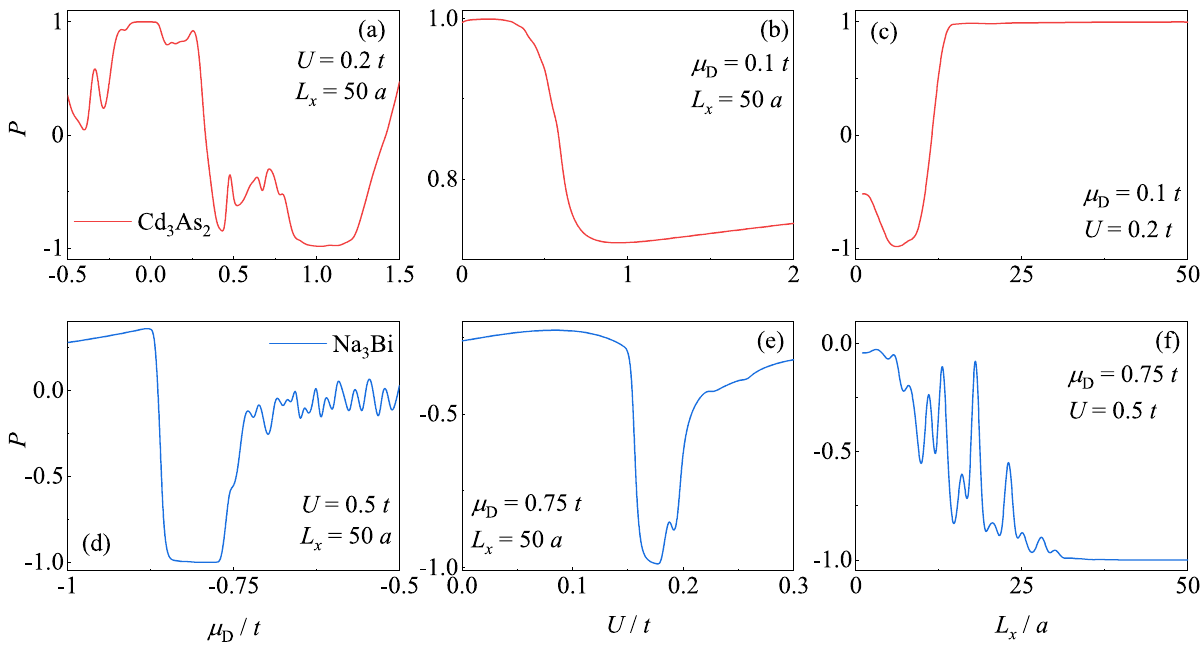
Figure 6. The current polarization tuned by ( a , d ) voltage gate, ( b , e ) barrier and ( c , f ) the length of the junction made by Cd 3 As 2 (top panel) and Na 3 Bi (bottom panel). The model parameters are shown in Table 1. The Fermi level is E = 0.2 t and the magnetic field is B z = 5 T. Other parameters are shown in the